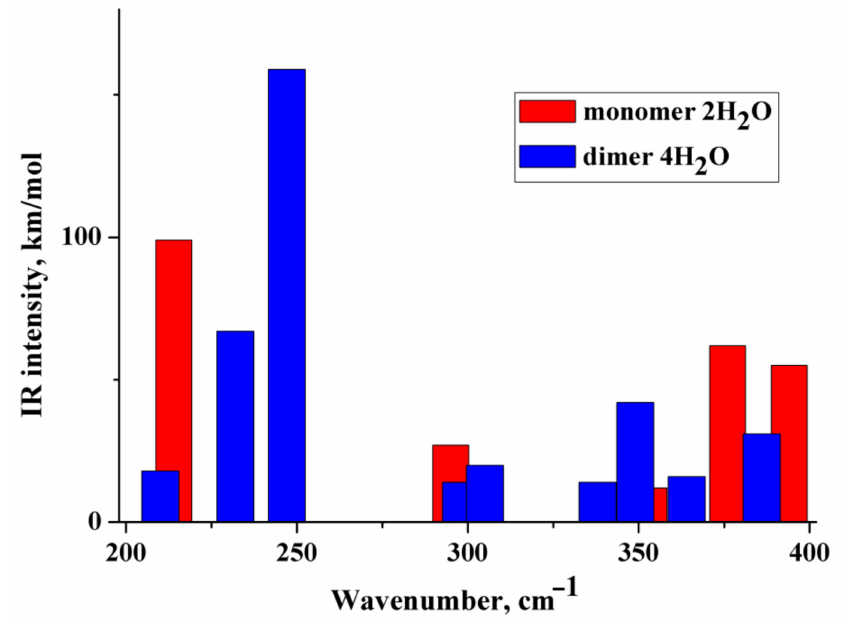
Figure 3. Theoretical IR spectra of the diclofenac anion hydrated with two water molecules (red columns) and dimer of the diclofenac anion hydrated with four water molecules (blue columns).